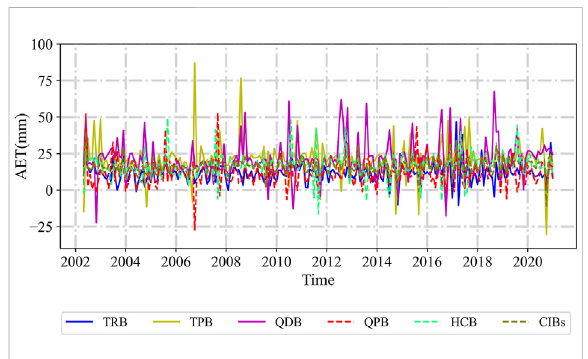
FIGURE 7 The deseasonalized series of actual evapotranspiration (AET) in the Chinese inland basins (CIBs) and each sub-basin. The results were calculated based on water balance combined with fi ve Gravity recovery and climate experiment (GRACE) solutions and precipitation data. TRB, TPB, QDB, QPB, and HCB indicates